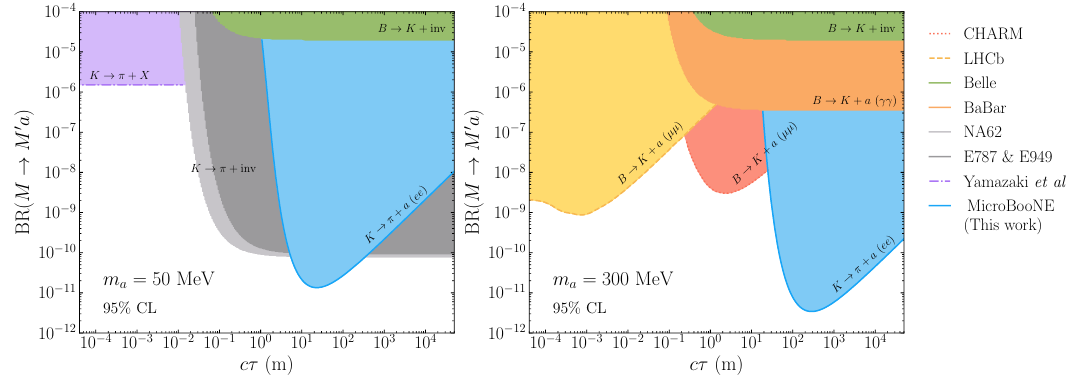
Figure 1 . MicroBooNE bounds (at 95% C.L.) in the plane of cτ vs the ALP production branching ratio, for two different ALP masses as indicated by the labels (blue regions). Our bounds are obtained from a reanalysis of the data in ref. [29], which used 1 . 93 × 10 20 Protons on Target (PoT) and looked for e + e − pairs. For comparison we also show the constraints (at 90% CL) from invisible decays derived from Belle [42], NA62 [40, 41] and E787 & E949 [20] data, as well as the constraints (at 95% CL) from searches for visible ALP decays from LHCb [18, 19] and CHARM [23, 36] (taken from ref. [37]), and from BaBar data [38]. Note that the LHCb and CHARM constraints only apply to ALP masses m 2 m while the limits from NA62 and E787 & E949 only apply for a > µ m a < m K − m π . We also show the constraints from Yamazaki et al. [44] which apply regardless of the ALP lifetime, see text for details. In this figure we only show constraints obtained from on-shell production of the ALP in meson